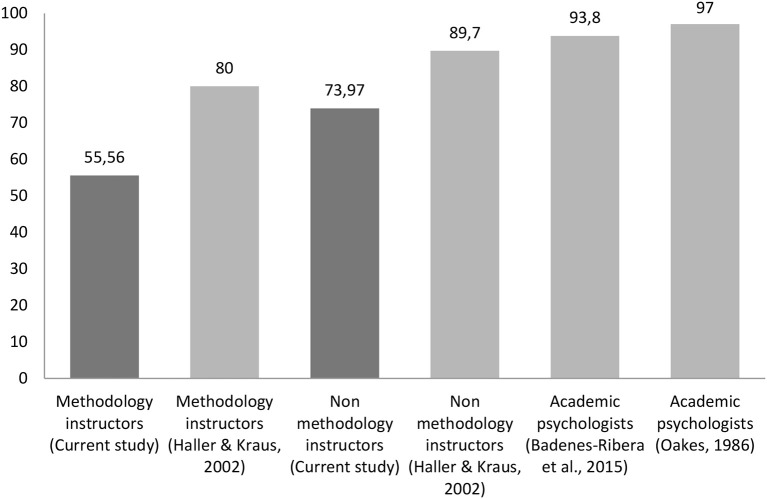
Percentages of participants in each group who endorse at least one of the false statements in comparison to the studies of Badenes-Ribera et al. (2015a), Haller and Krauss (2002), and Oakes (1986).